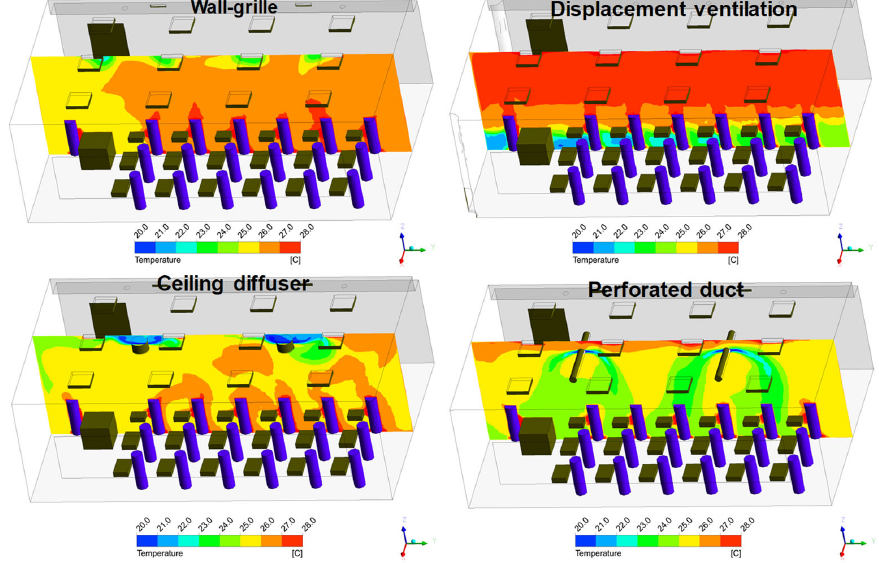
Buildings 2022 , 12 , x FOR PEER REVIEW Figure 10. Air temperature in the middle cross ‐ section plane of classroom in summer. Figure 10. Air temperature in the middle cross-section plane of classroom in summer.